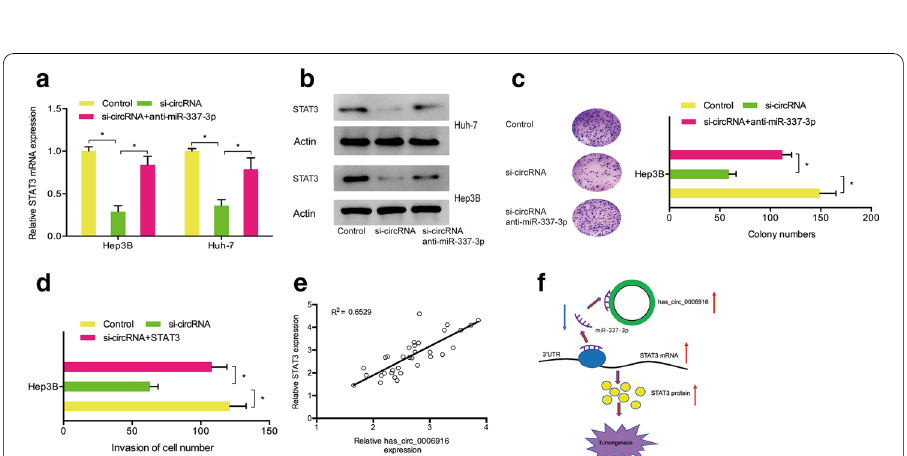
Fig. 6 Hsa_circ_0006916/miR‑337‑3p/STAT3 axis in hepatocellular carcinoma. a , b miR‑337‑3p inhibitors rescued the effect of hsa_circ_0006916 suppression on STAT3 levels. c , d MiR‑337‑3p inhibitors rescued the effect of hsa_circ_0006916 silencing on growth and invasion of Hep3B cells. e Hsa_circ_0006916 is related to miR‑337‑3p in hepatocellular carcinoma. f The hsa_circ_0006916/miR‑337‑3p/STAT3 axis in hepatocellular carcinoma. * p <